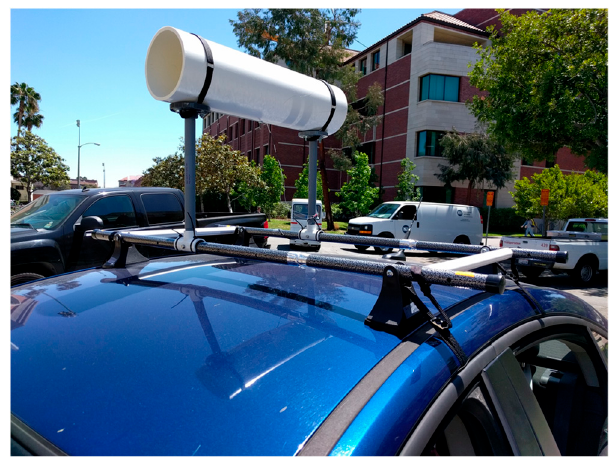
Figure 3. Mobile-transect apparatus.